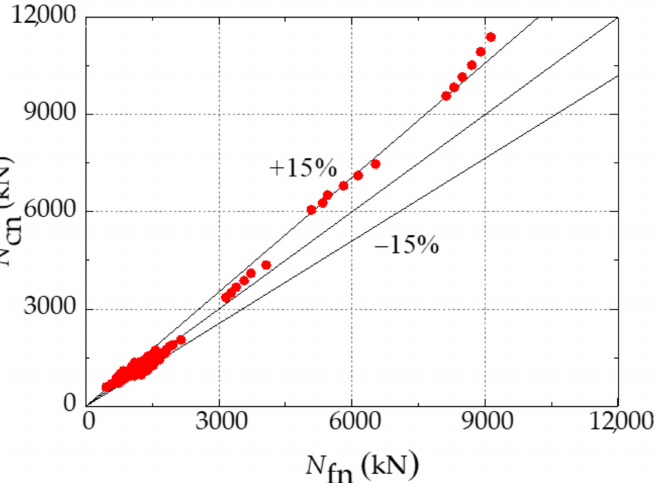
Figure 10. Comparison between the ultimate bearing capacity obtained by numerical modelling and simplified